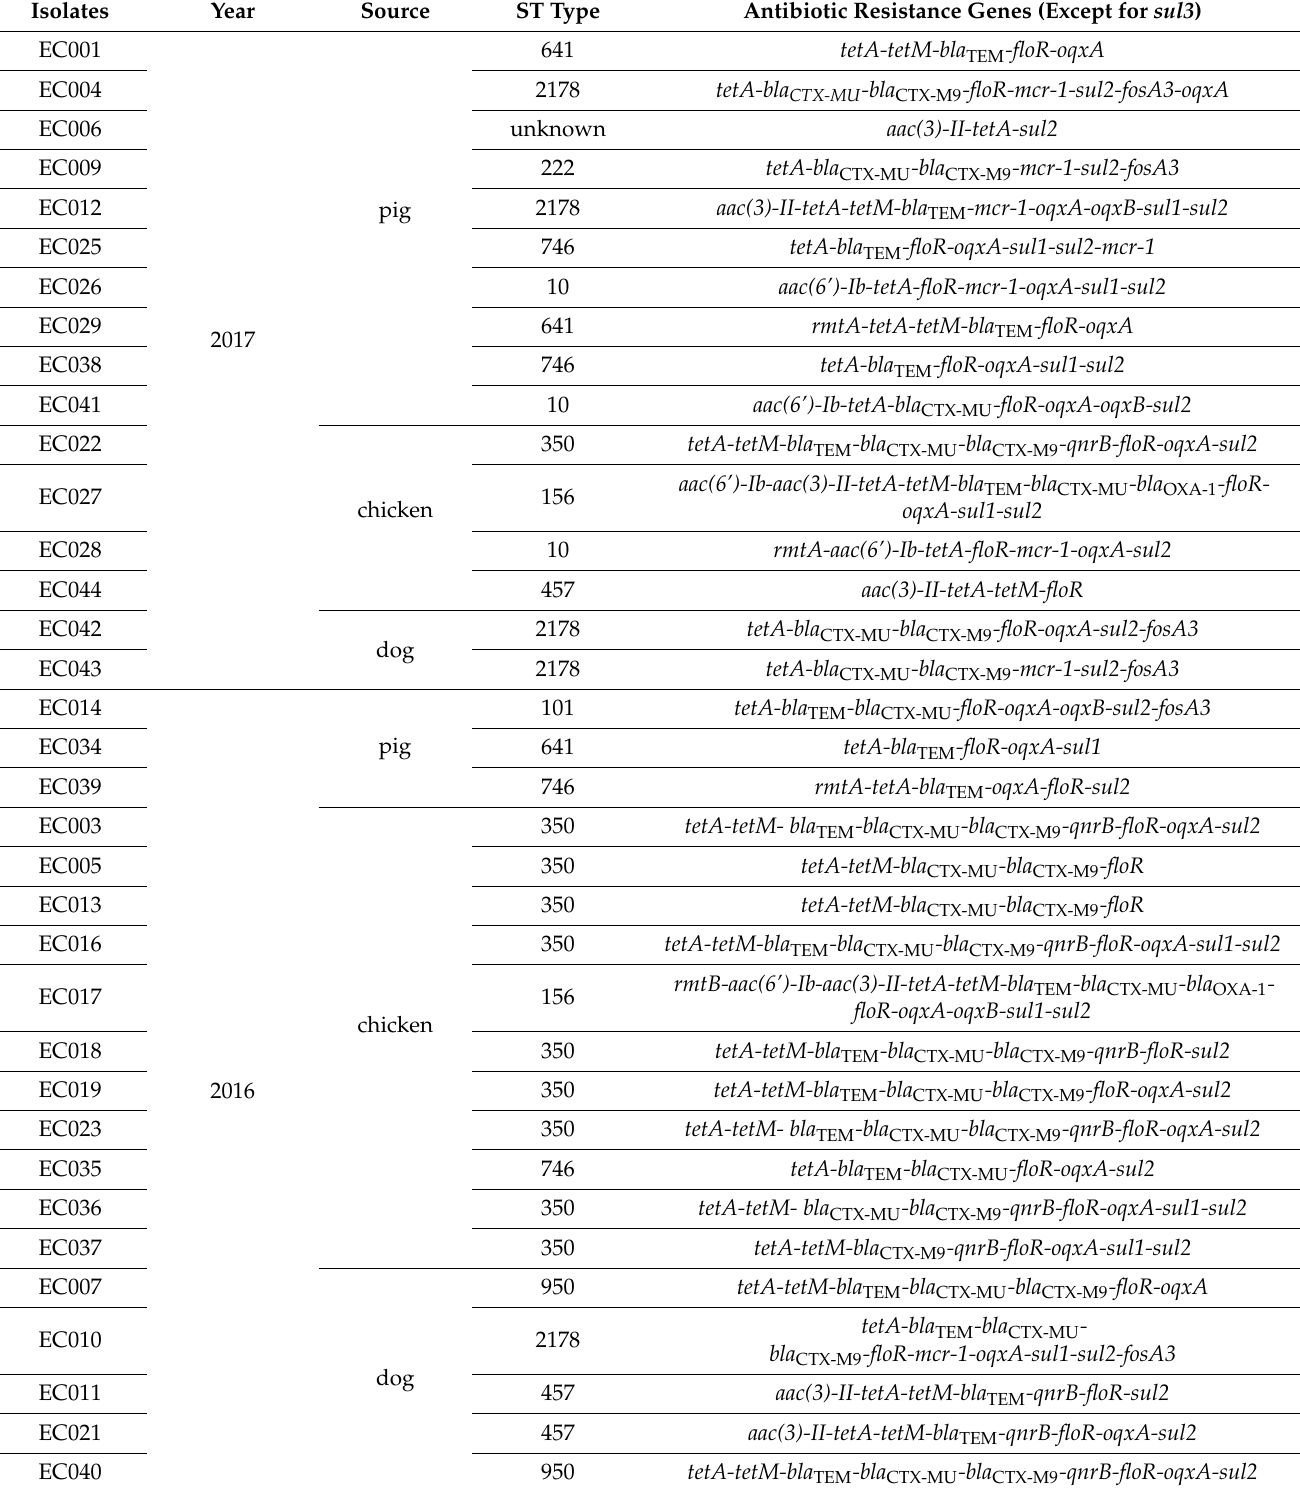
Table 3. Strain information, MLST typing and antimicrobial resistance